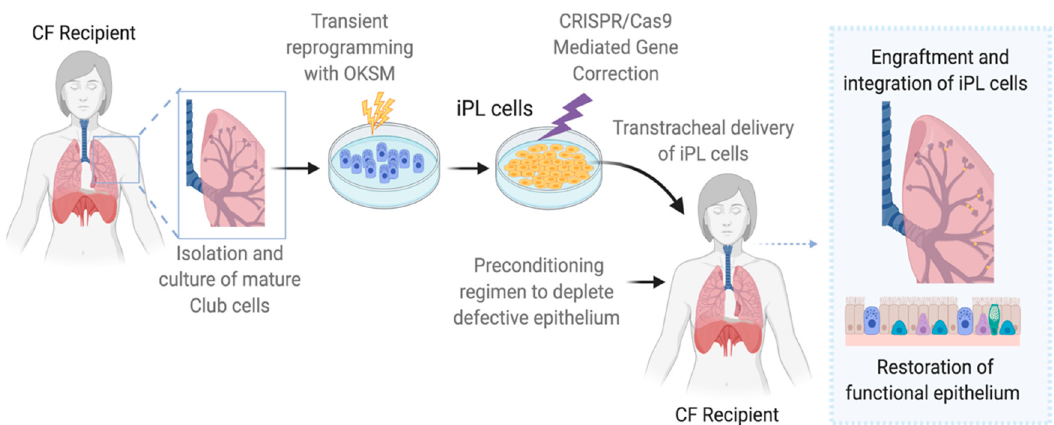
Figure 2. Schematic representation of the Induced progenitor-like cells (iPL) process and their utility in cell therapy for Cystic Fibrosis (CF). iPL are generated from mature club cells isolated from a CF patient via transient reprogramming with Oct4 , Sox2 , Klf4 , and c-Myc (OKSM). Gene corrected iPL cells are then transplanted back to the preconditioned recipient airways where they will engraft and integrate into the airways and restore the epithelium. Figure created with BioRender.com.